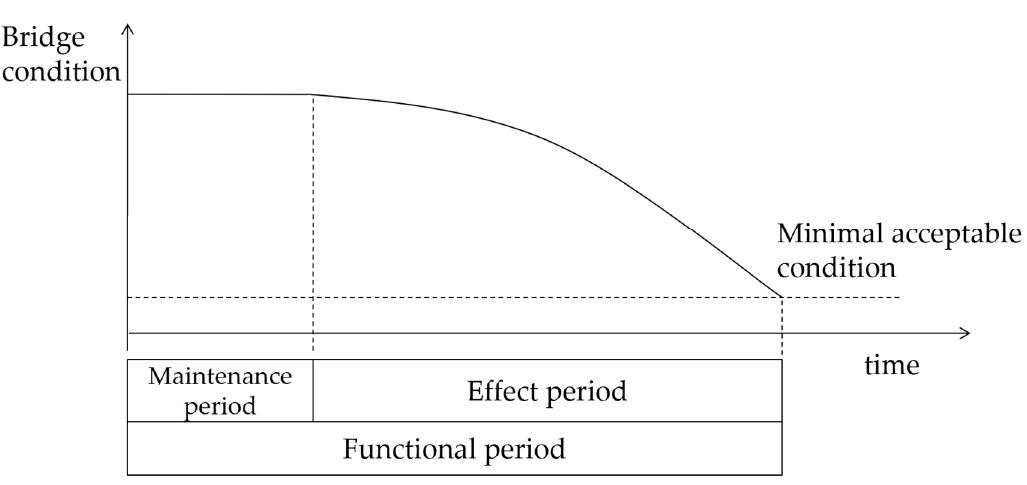
Figure 1. Illustration of bridge maintenance effect.